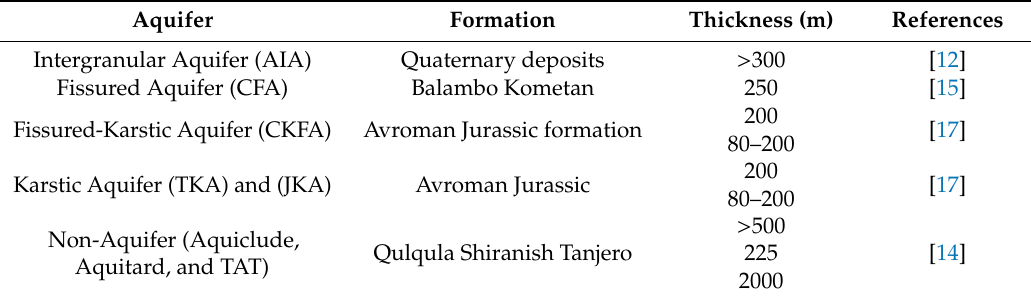
Table 1. Aquifers in the